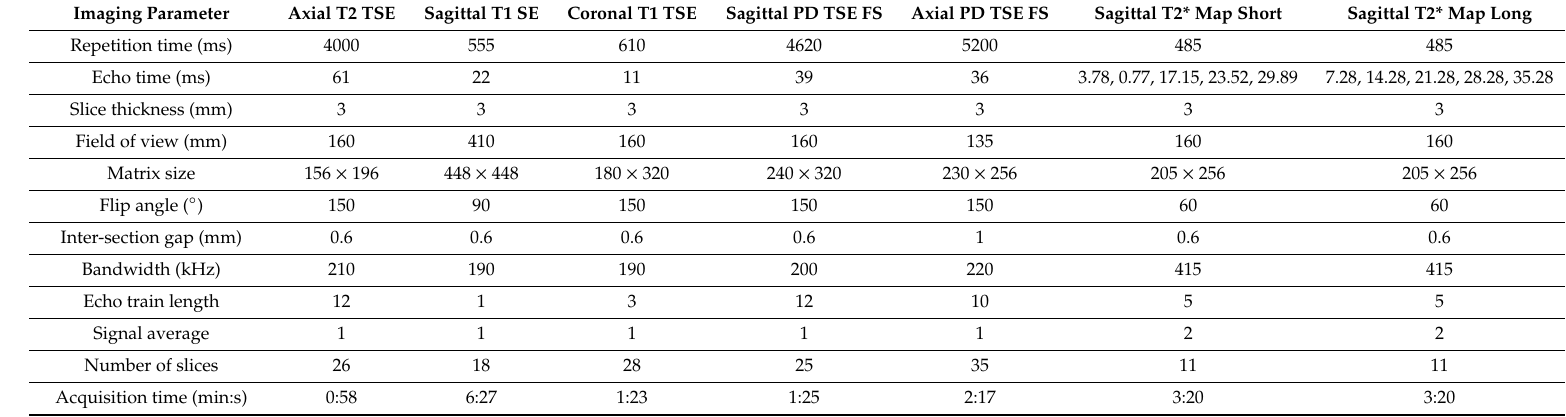
Table 2. Imaging parameters for magnetic resonance imaging sequences used for morphological evaluation of the